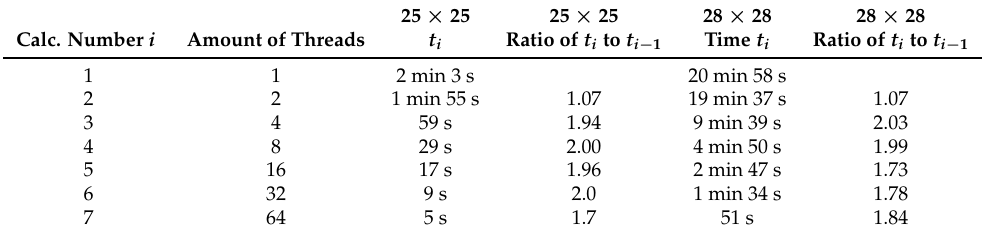
Table 3. Performance of the parallel algorithm of 25 × 25 and 28 × 28 lattices calculation for 1, 2, 4, 8, 16, 32 and 64